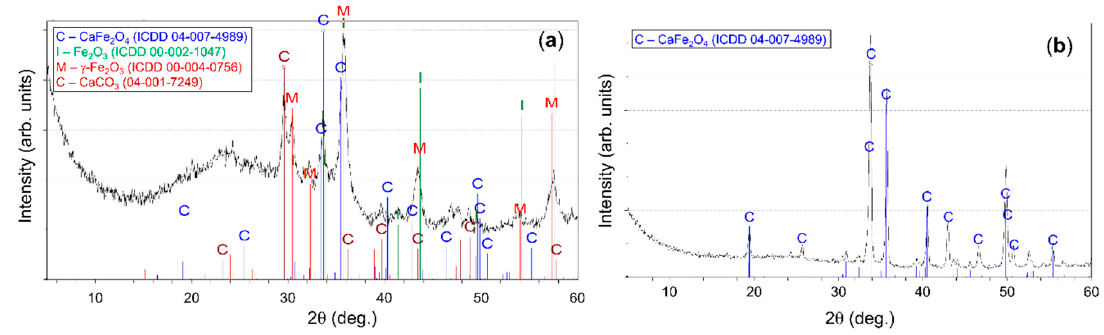
Figure 1. ( a ) X-ray diffraction (XRD) pattern of as–prepared and ( b ) annealed powders. Reproduced with permission from [7].